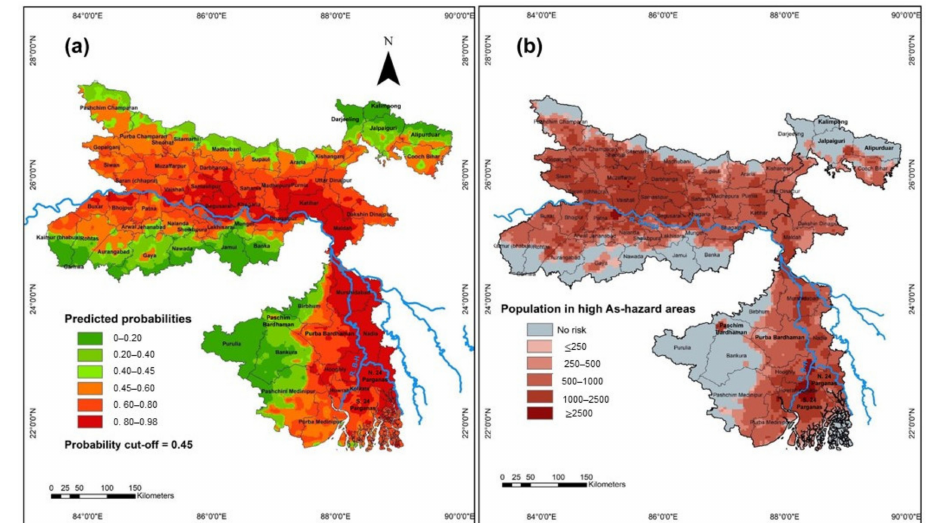
Figure 3. Map showing ( a ) Random forest predicted probabilities of groundwater arsenic (As) exceeding the permissible limit of 10 µ g/L and indicating the probability cut-off of 0.45. ( b ) Population in predicted high risk areas of groundwater